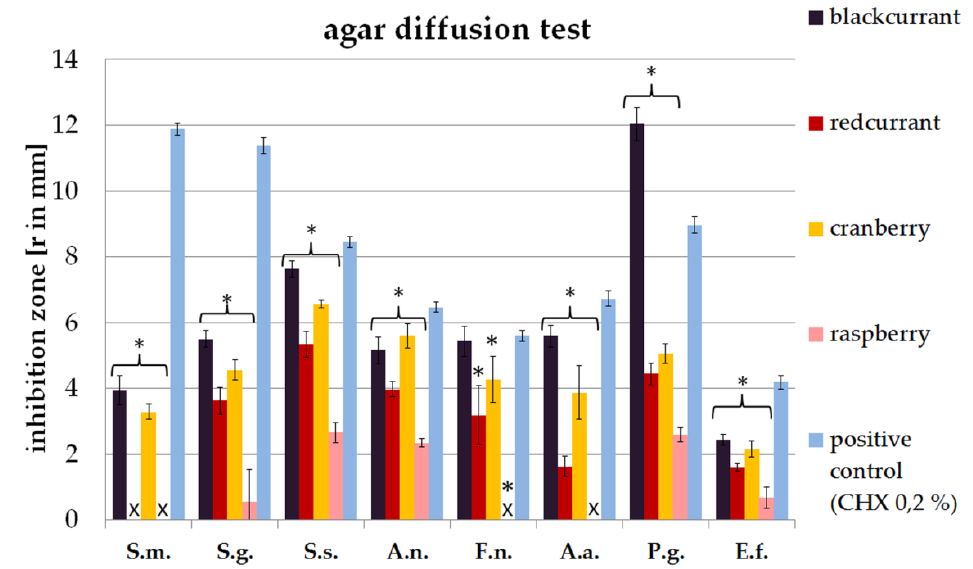
Figure 1. Antibacterial effect of the berry juices evaluated by an agar diffusion assay. Stars (*) indicate significant difference to the positive control ( p < 0.05). X represents absence of any inhibition zones. ( Streptococcus mutans -S.m.; Streptococcus gordonii -S.g.; Streptococcus sobrinus -S.s.; Actinomyces naeslundii -A.n.; Fusobacterium nucleatum -F.n.; Aggregatibacter actinomycetemcomitans -A.a.; Porphyromonas gingivalis -P.g.; Enterococcus faecalis